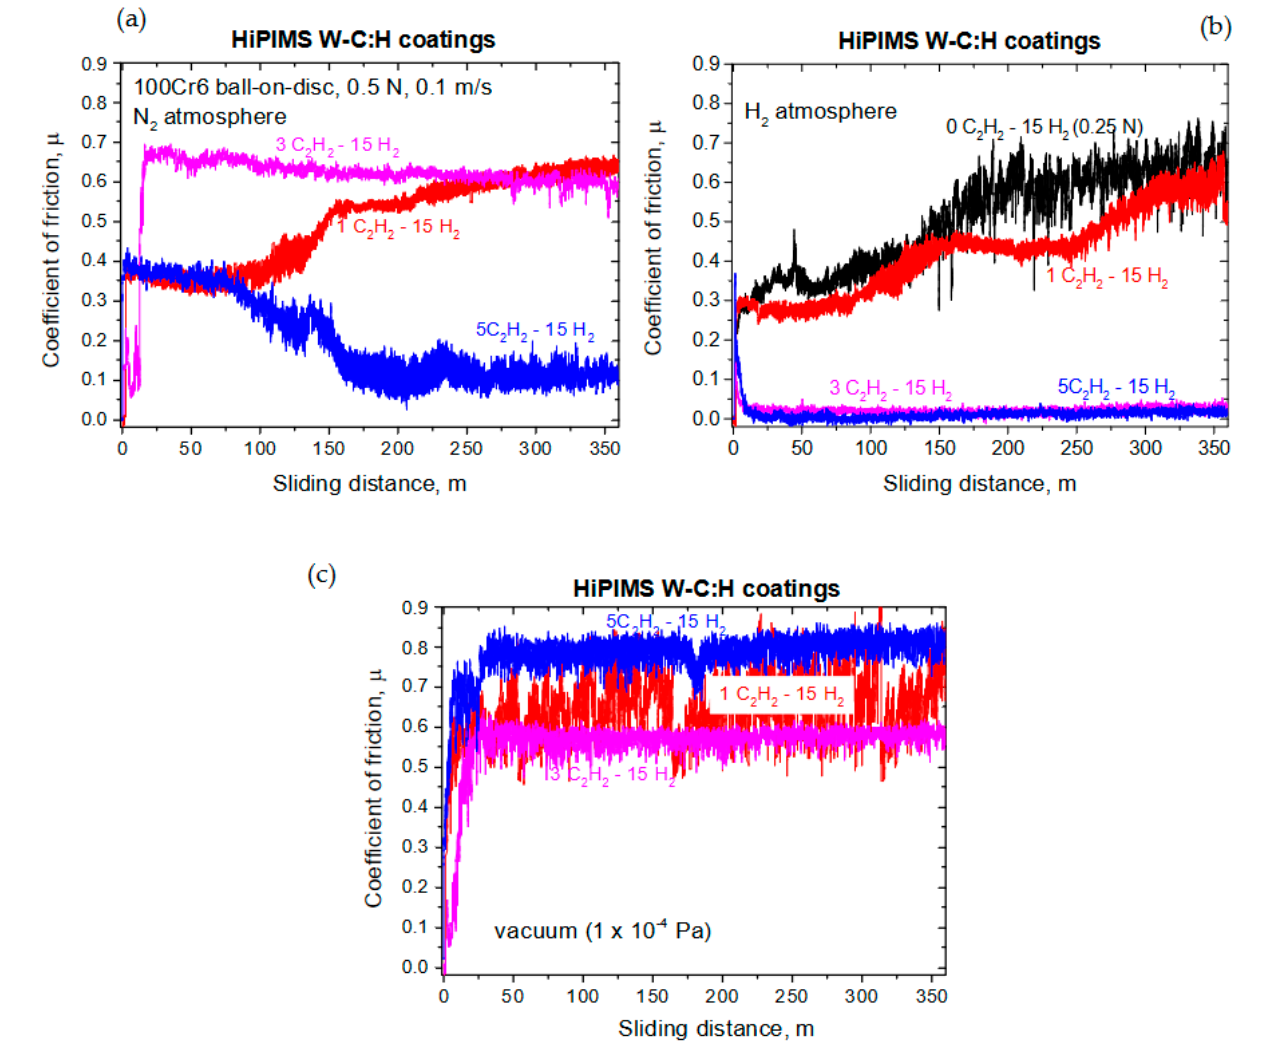
Figure 15. Friction curves in W-C:H coatings deposited with different amounts of C 2 H 2 + 15 sccm H 2 obtained in ( a ) dry (<2 ppm H 2 O) nitrogen, ( b ) dry (<2 ppm H 2 O) hydrogen and ( c ) vacuum (1 × 10 − 4 Pa).